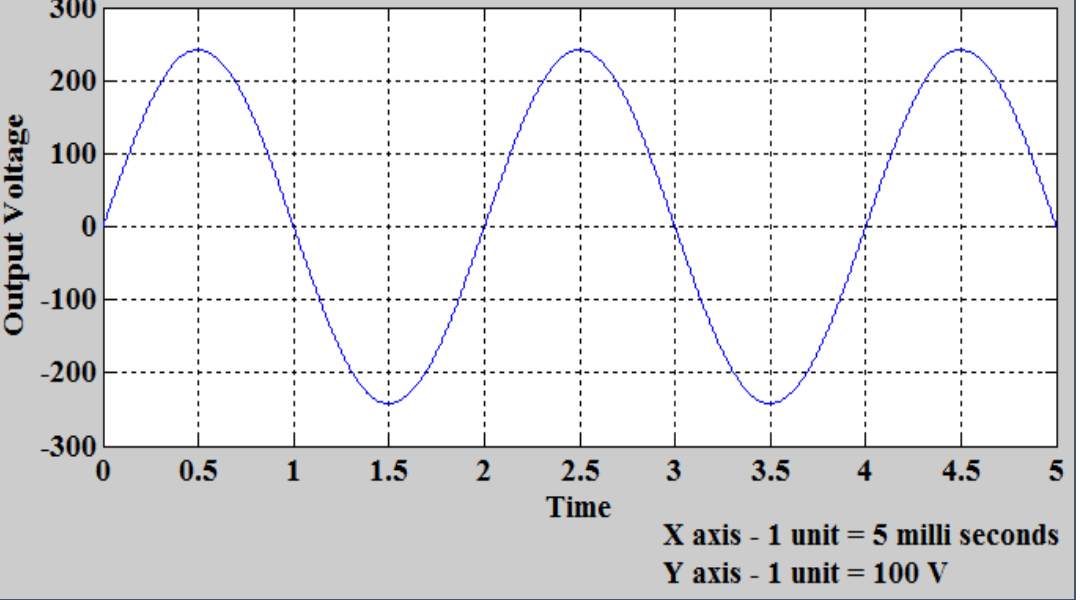
Figure 19. Output voltage vs. Time—RL load (50 + j31.4) ohm—Simulation.